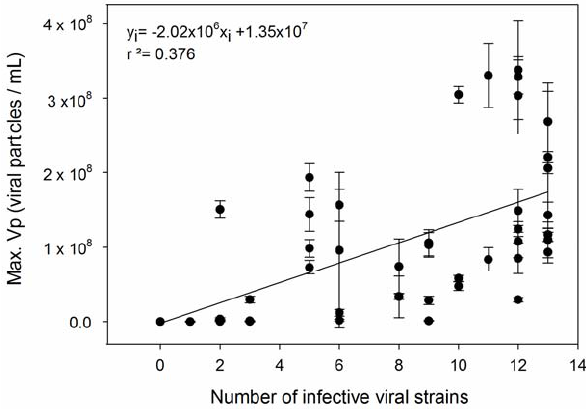
Figure 4. Number of viral strains infecting each algal strain and maximum viral production correlation. Error bars show standard deviation ( n = 3).